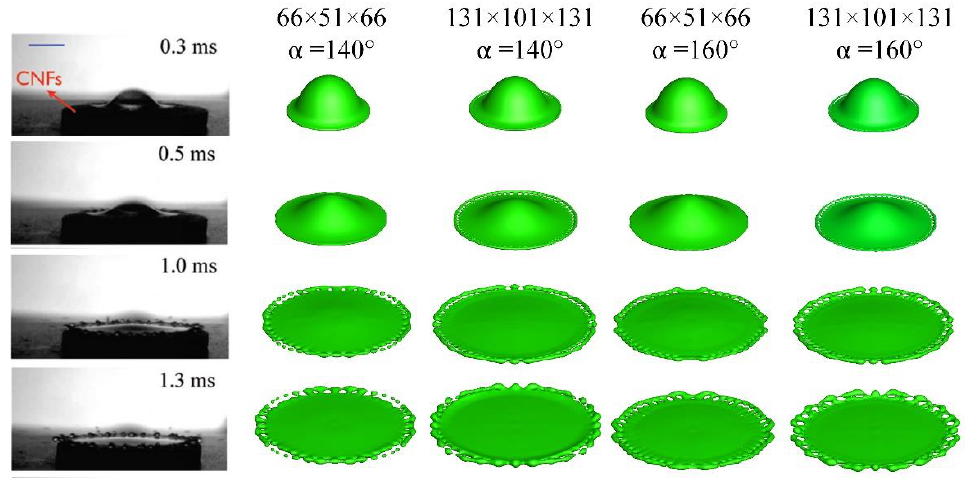
Figure 6. Mesh sensitivity study.